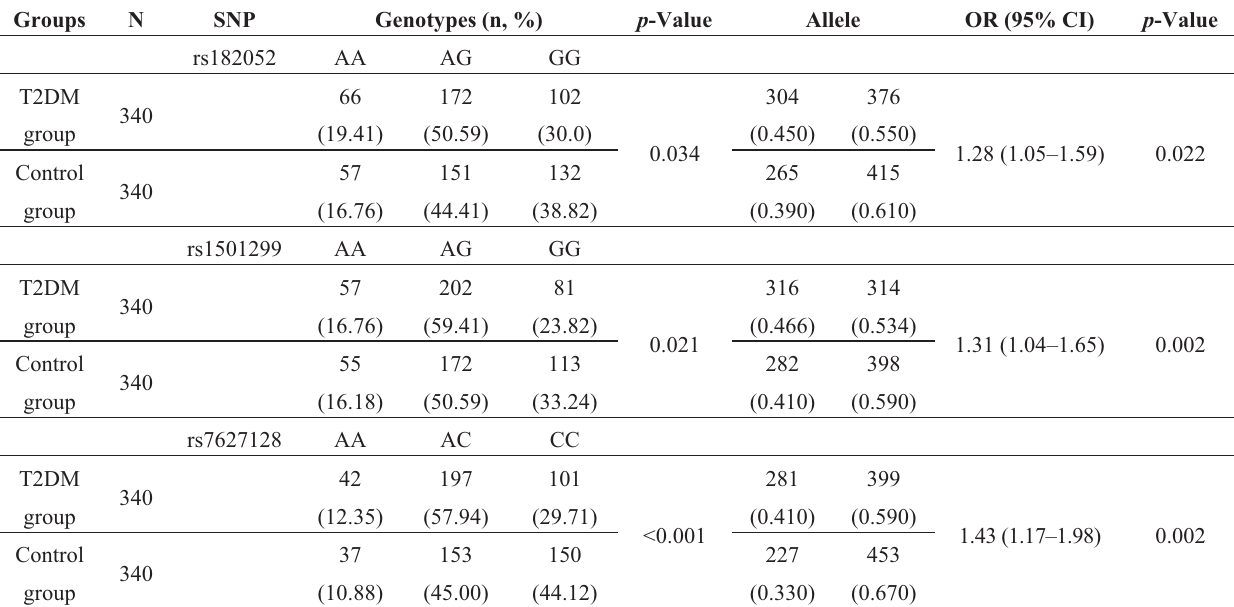
Table 2. Distributions of the ADIPOQ genotype.